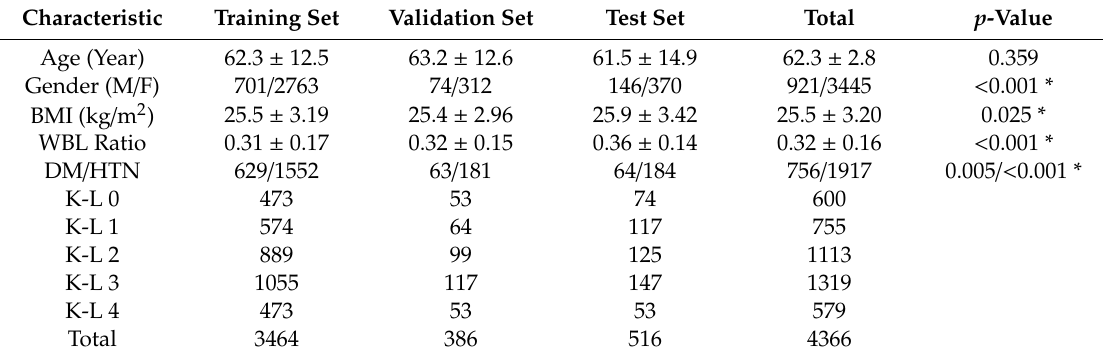
Table 1. Baseline